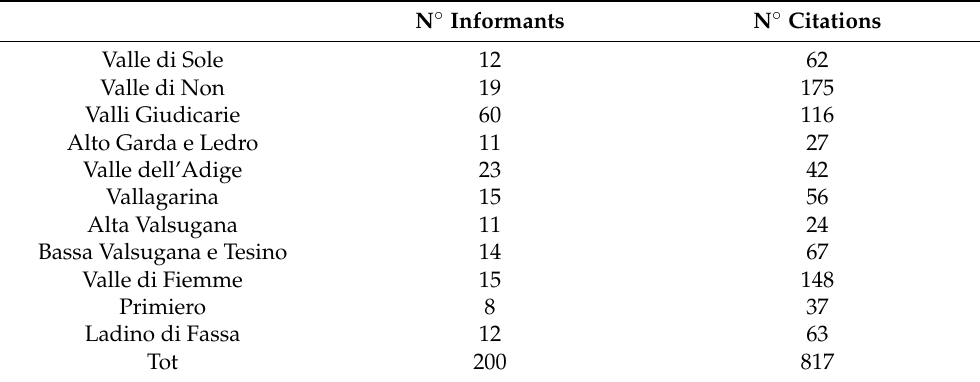
Table 3. Distribution of the 200 subjects interviewed in Trentino-South Tyrol based on the 11 districts in which the study area is divided.